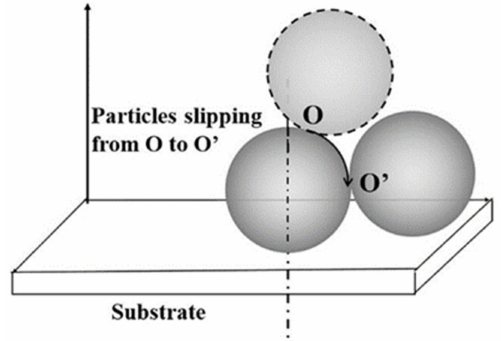
Figure 8. Schematic of slipping deposition of semi-molten particles.